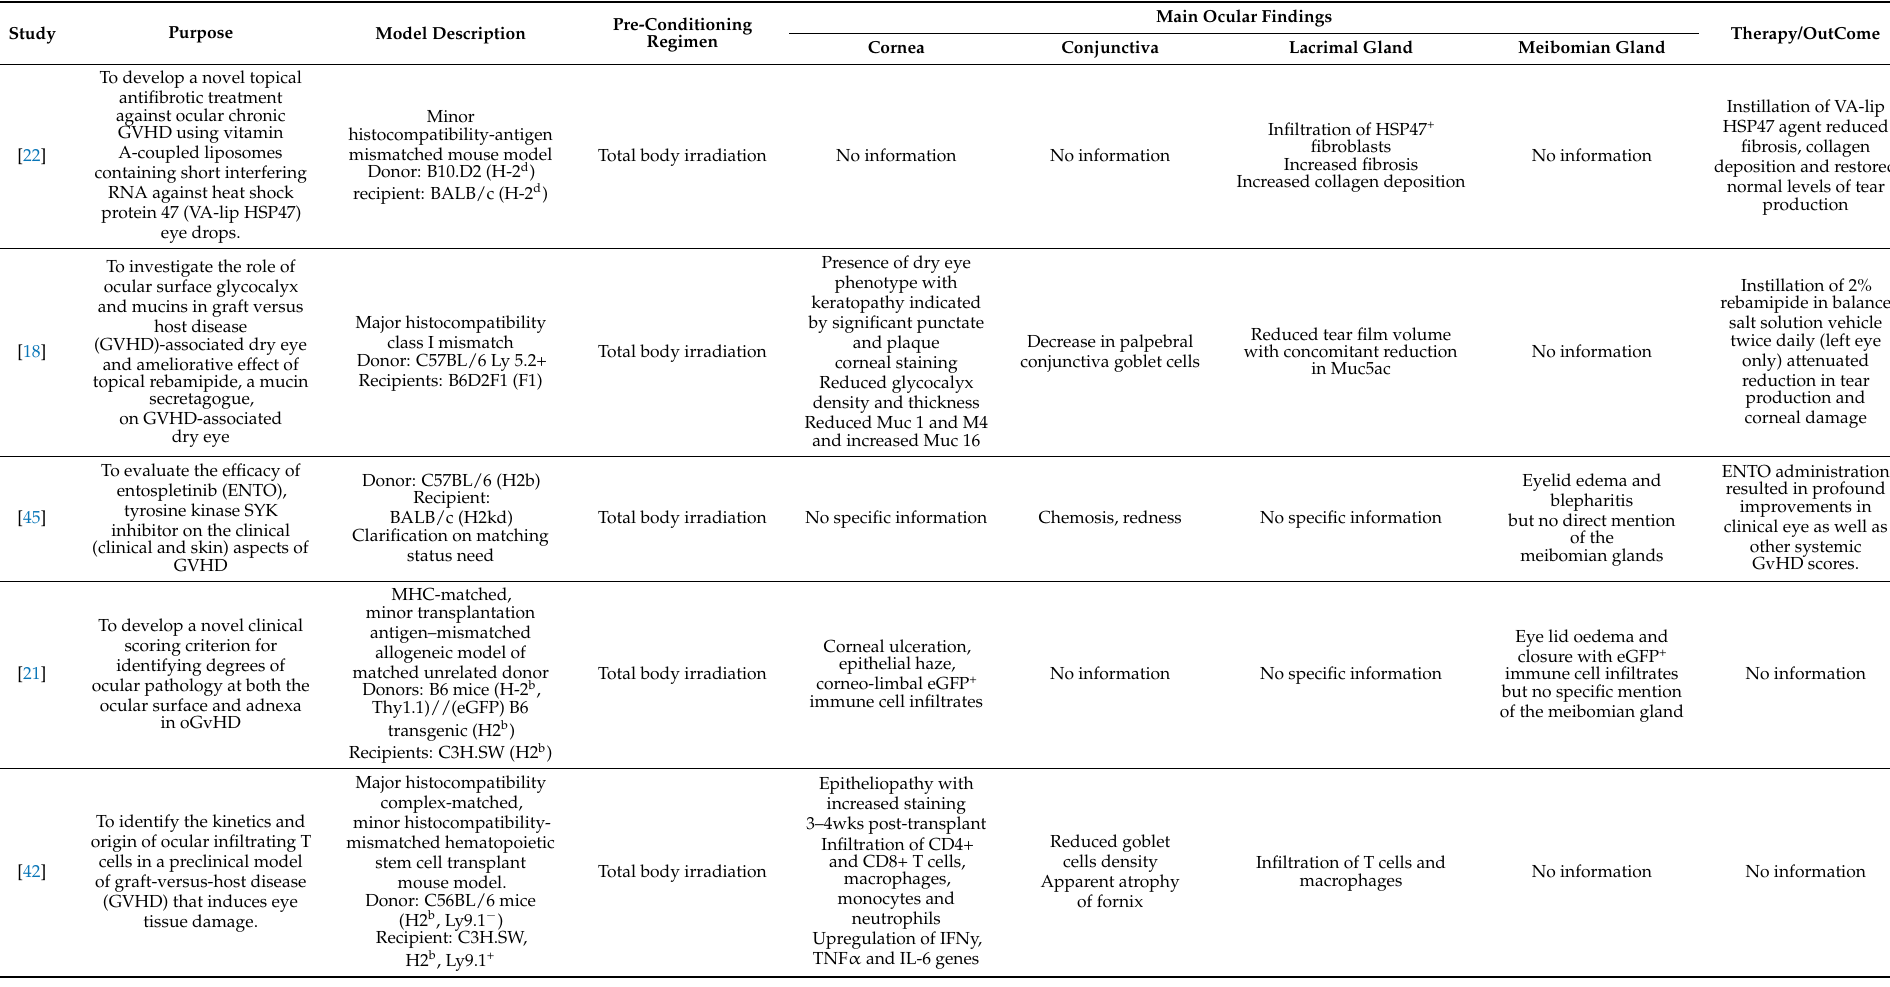
Table 1. Summary of pre-clinical animal models of ocular graft-vs-host disease and their key ocular